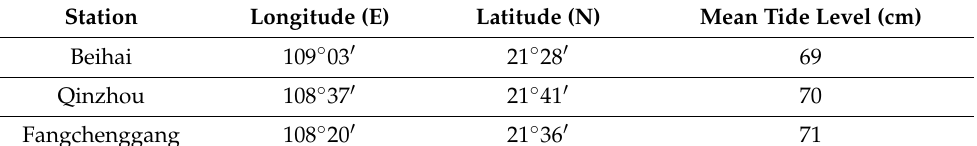
Figure 2. Surface distributions of salinity ( a ) and temperature ( b ) during our investigation period in May 2021.